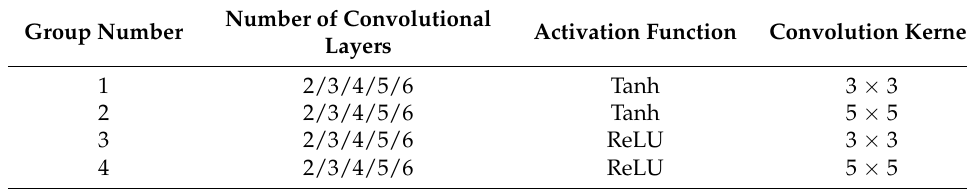
Table 1. Experiment grouping situation.